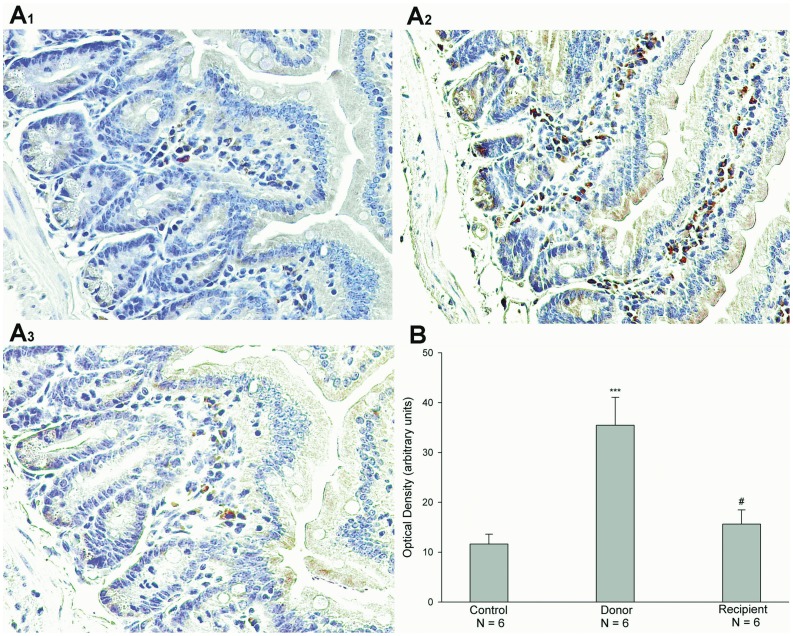
Immunohistochemical analysis of TNFα expression. (A) Representative images for TNFα expressions in the jejunal mucosae of control (A1), donor (A2), and recipient (A3).The brown immunostainings in the cells are TNFα. TNFα is located in the monocytes of intestinal mucosa, and there are not the expressions of TNFα in both villous and cryptal epithelial cells of intestinal mucosa. (B) Expression levels of TNFα in the jejunal mucosae of control, donor, and recipient. The results are expressed as optical density (arbitrary units). Values are mean ± SEM and n = 6 in each series. The expression level of TNFα in the jejunal mucosa of donor was higher markedly than that in control, but there was no significant difference between the expression levels of TNFα in the jejunal mucosae of recipient and control. ***P<0.001, #
P>0.05.